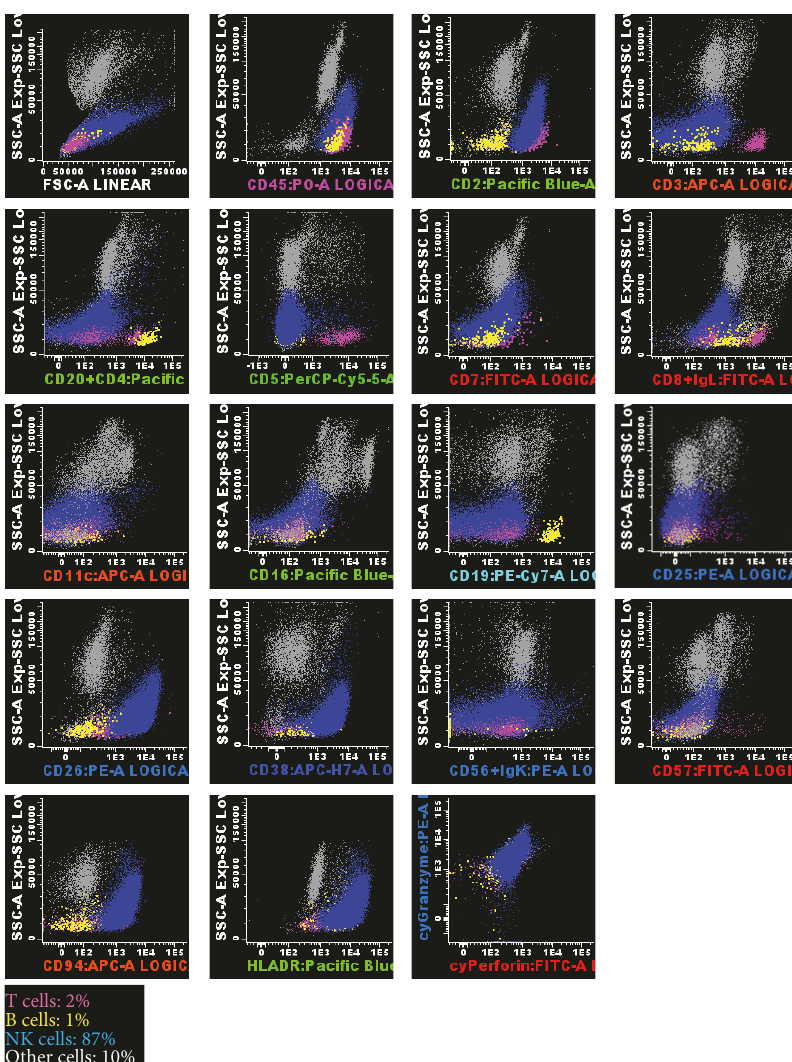
Figure 3: Flow cytometry studies in the bone marrow aspirate, using the EuroFlow lymphoid screening tube (LST) and antibody panel for NK cell chronic lymphoproliferative diseases (NK-CLPD), consisting of 8-color combinations of monoclonal antibodies (7), and a FACSCanto II flow cytometer (Becton Dickinson). Data analysis was performed using the Infinicyt software (Cytognos, Spain). Dot-plots illustrate the phenotypic features of the neoplastic NK cells. Blue dots correspond to the neoplastic NK cells whereas pink dots and yellow dots are the normal residual T cells and B cells present in the bone marrow sample. Other cells are represented as gray dots. The abnormal NK cells were positive for surface CD45 (high), CD2, CD26, CD38, CD94 (high), and HLA-DR and cytoplasmic granzyme B and perforin; and they were negative for surface CD3, CD4, CD5, CD7, CD8, CD11c, CD16, CD19, CD20, CD25, CD56, Ig kappa, and lambda chains.